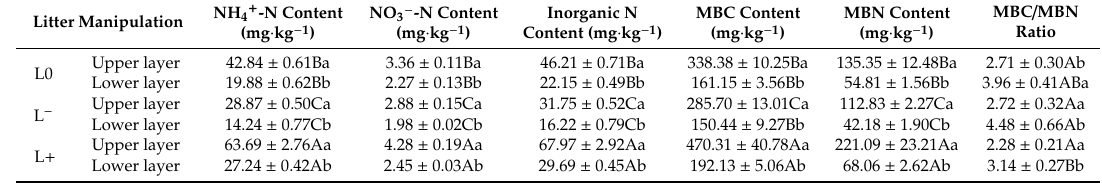
Mean ± Standard deviation, n = 9. Different capital letters indicate significant differences between manipulations in each soil layer ( p < 0.05). Different lowercase letters indicate significant differences between soil layers.